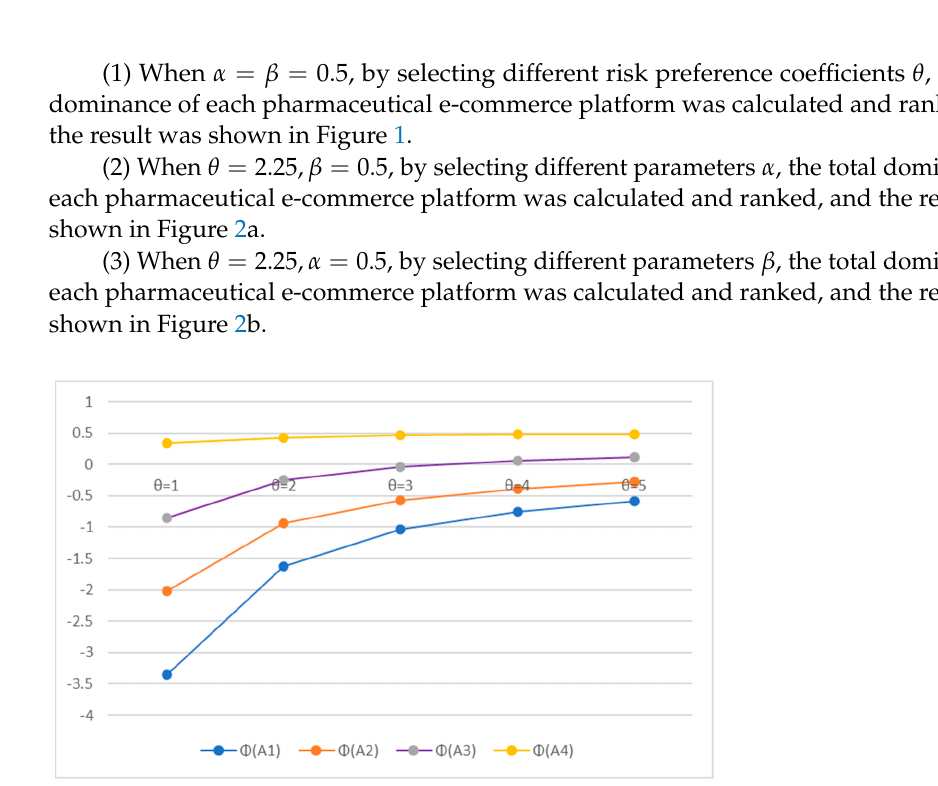
Figure 1. Influence of different values of θ on pharmaceutical e-commerce platform ranking.